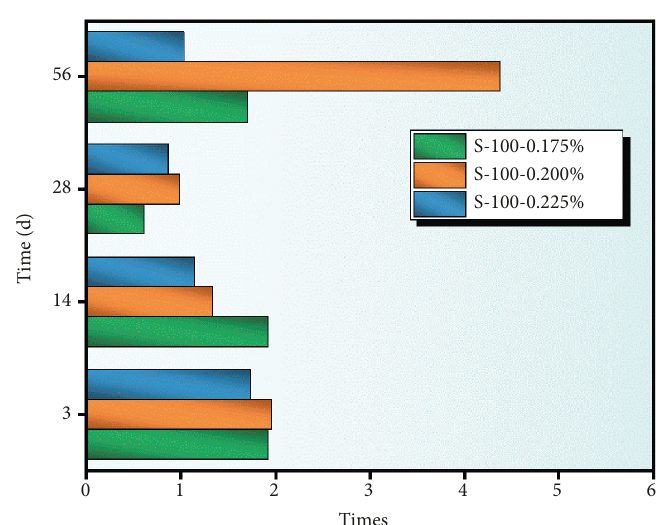
Figure 12: Ratio of Ca(OH) 2 peak area in hydration products at different